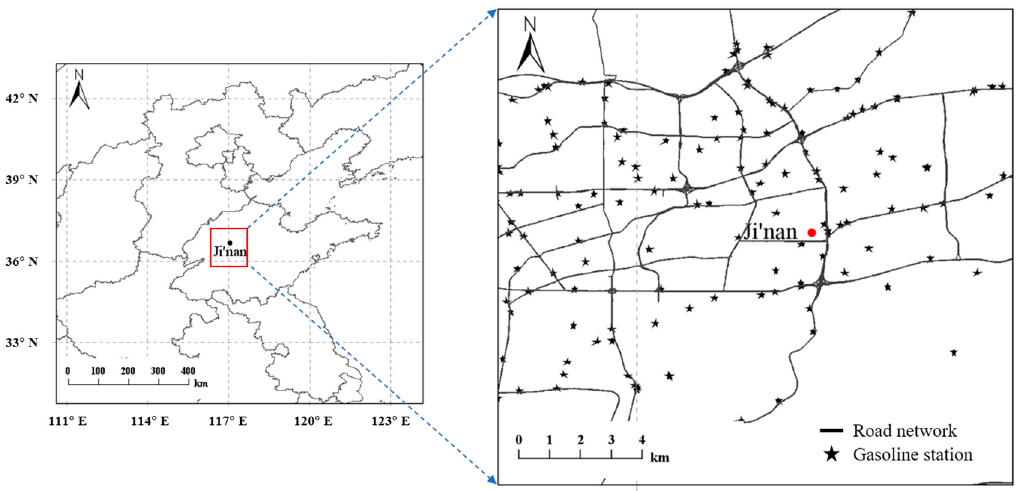
Figure 1. Locations of the measurement site and gasoline stations in Ji’nan. Ambient NMHCs were pre-concentrated by two capillary columns filled with absor- bents (enrichment trap and focus trap) at room temperature (about 25 °C), and then were vaporized and injected into a gas chromatography (GC) system equipped with a flame ionization detector (FID) and a mass spectrometer detector (MSD) (GCMS-QP2020, Shi- madzu Cooperation, Kyoto City, Japan) for separation and detection. Except for the three species with two carbon atoms, the other target NMHCs were separated on a DB-1 column (0.25 mm × 60 m × 1 μ m, Agilent Inc., Santa Clara, CA, USA). The oven temperatures for the GC-MS/FID system initiated at 35 °C which was held for 10 min, then increased from 35 °C to 100 °C at 10 °C/min and was held for 5 min at 100 °C, then increased to 220 °C at 10 °C/min and was then held for 3 min at 220 °C, followed by an increase to 240 °C at 10 °C/min, which was then held for 3.5 min. Fifty-seven NMHC species were quantified by using this GC-MS/FID system, including 29 alkanes, 11 alkenes, acetylene, and 16 aromat- ics. The mixed 1-ppm standard gas for 57 NMHCs (Spectra gasses Inc., Branchburg, NJ, USA) was diluted to 6 calibration standards with mixing ratios of 0.5 ppbv, 2 ppbv, 3 ppbv, 4 ppbv, 8 ppbv, and 10 ppbv. Correlation coefficient ( r ) values of calibration curves ranged from 0.99 to 1.00. The method detection limits (MDL) for these NMHC species were in the range of 0.009–0.161 ppbv.